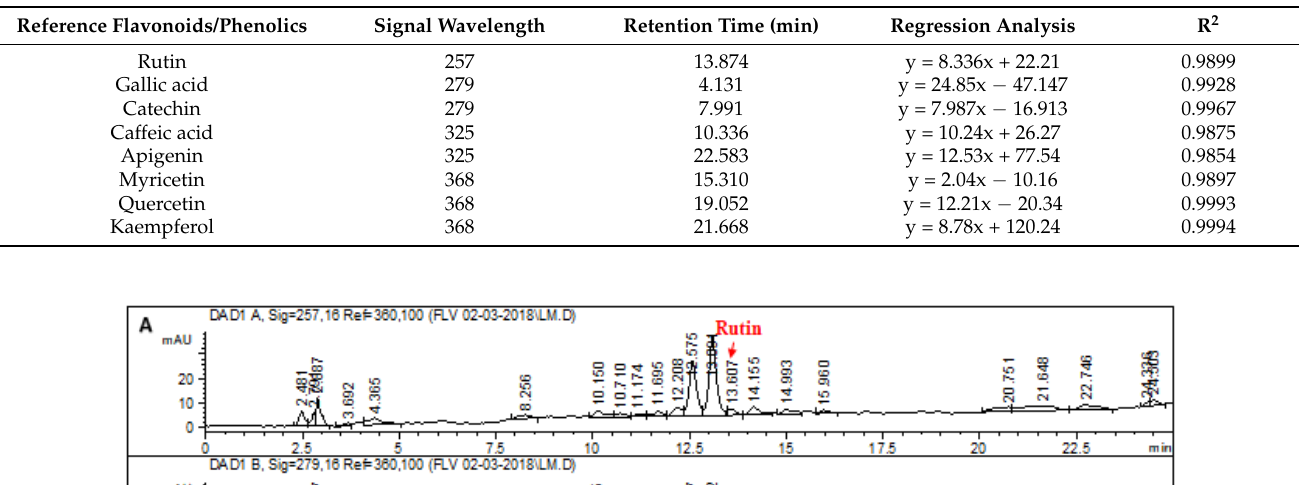
Table 1. Retention time, optimized wavelength and regression analysis of reference flavonoids and phenolics for L. corymbulosum methanol extract and derived fractions.